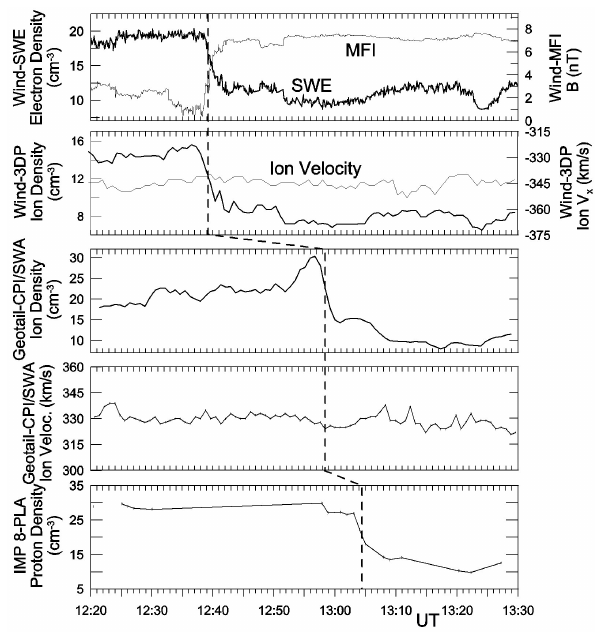
Fig. 12. The vertical dashed line defines the solar wind pressure drop that occurred on 7 August 1997. From top to bottom the Wind/SWE electron density (thick line) and the Wind/MFI mag- netic field strength (thin line), the Wind/3DP ion density (thick line) and velocity (thin line), the Geotail/CPI/SWA ion density and ve- locity, and the IMP-8/PLA proton density are shown. The pressure variation does not change the solar wind velocity.